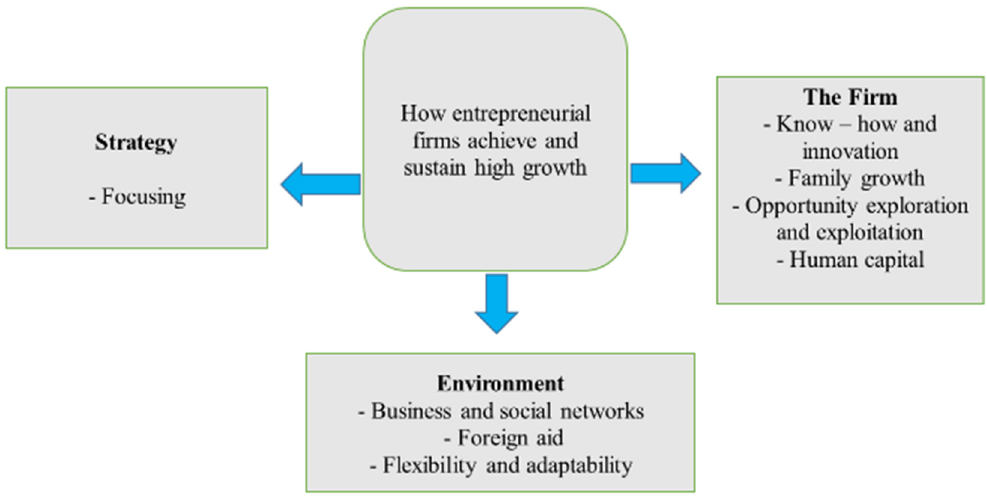
Figure 1. How entrepreneurial firms achieve and sustain high growth in extreme context.